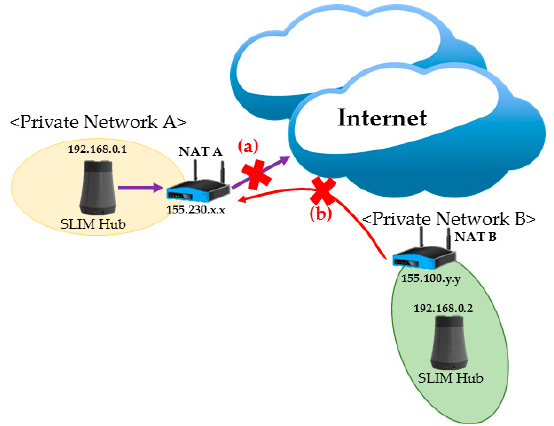
Figure 3. Problems of NAT device and private network.